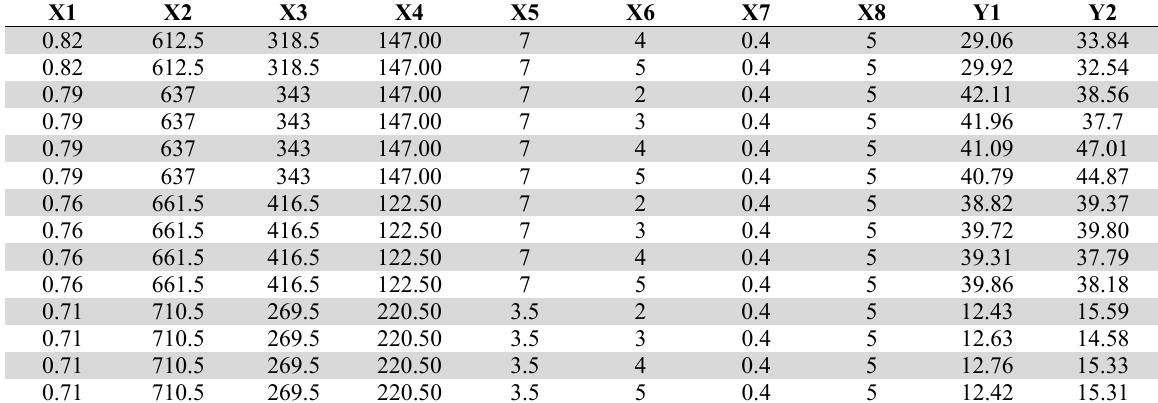
Sample of data set for the prediction of heating and cooling loads (Tsanas and Xifara (2012)